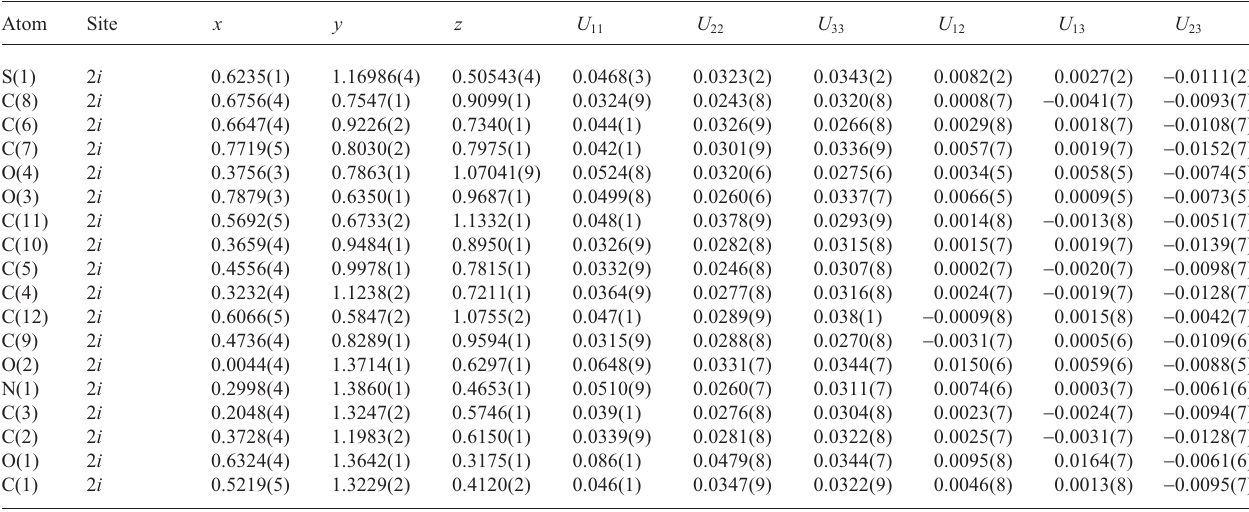
Table 3. Atomic coordinates and displacement parameters (in Å 2 )